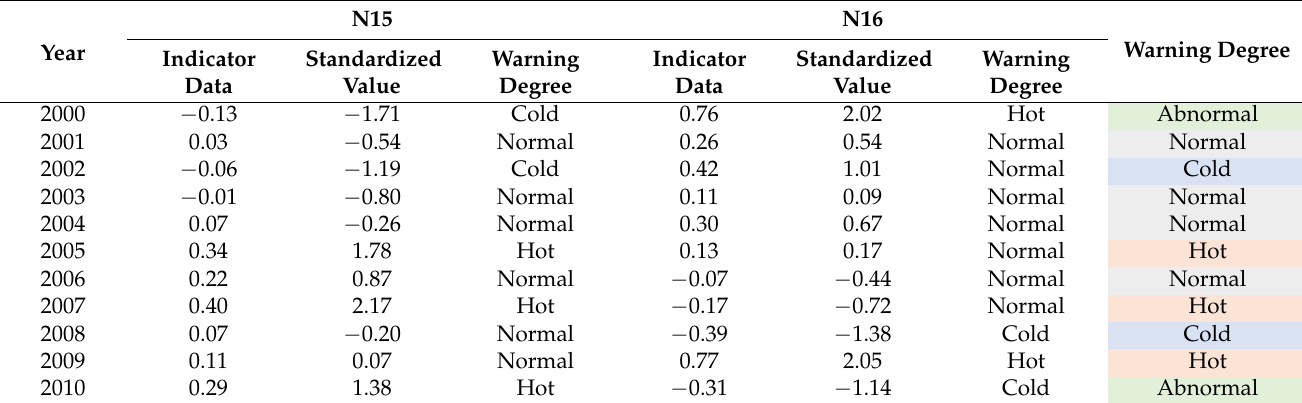
Table 5. The warning status of the Beijing real estate market from 2000 to